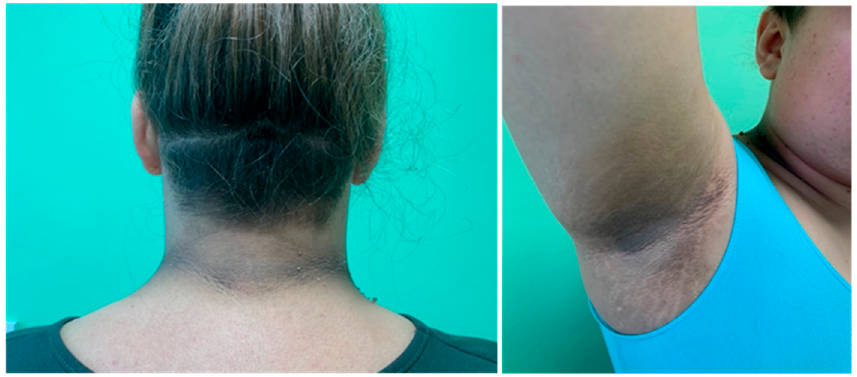
Figure 3. Acanthosis nigricans (authors’